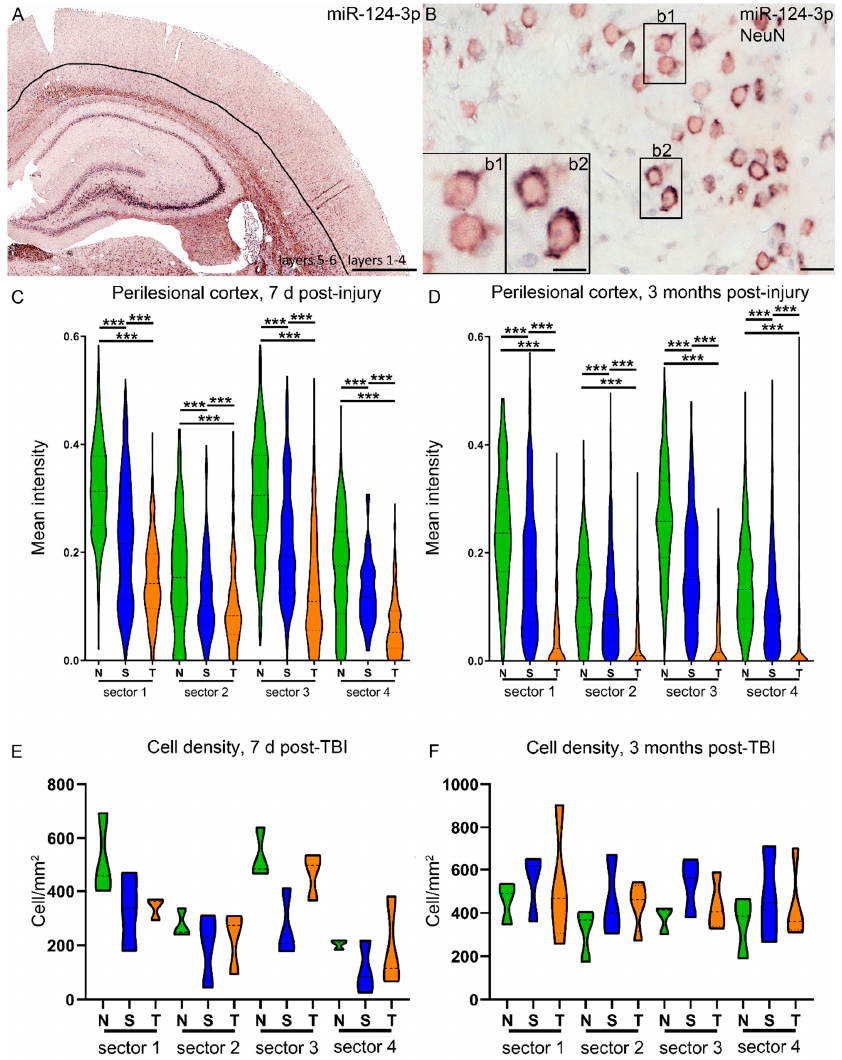
Figure 3. Perilesional expression of miR-124-3p is downregulated by lateral fluid-percussion injury as well as by craniectomy. ( A ) In situ hybridization was used to detect the distribution and intensity of cellular expression of miR-124-3p in di ff erent layers of the cortex. ( B ) Double-labeling with NeuN revealed that the expression level of miR-124-3p varied between the neurons in the perilesional cortex (inserts b1, b2). Our analysis focused on a 1-mm wide area of the dorsal perilesional cortex, which was further divided into four sectors (see Figure 1). The intensity of in situ hybridization signal was measured in the individual neurons within each sector (mean number of cells counted: 7 d, naïve 123; sham 89; TBI 94; 3 months, naïve 125; sham 151; TBI 63). ( C , D ) Naïve animals (N) showed a clear expression pattern at both 7 d and 3 months post-TBI, with a higher level of miR-124-3p expression in the deeper (s1, s3) than superficial layers (s2, s4). The proximal and distal sectors had similar expression levels (s1 vs. s3; s2 vs. s4). In sham-operated experimental controls (S) with a craniotomy, the overall pattern of miR-124-3p expression was preserved. At both time-points and within each of the four sectors, however, the miR-124-3p levels were downregulated compared with those in naïve animals ( p < 0.001). In rats with TBI (T), the miR-124-3p expression levels were even lower than those in sham-operated animals ( p < 0.001) in all sectors and at both time-points. ( E , F ) The cell density in the sectors did not di ff er between time-points or groups. N, naïve; S, sham; s1–s4, sector as described in Figure 1; T / TBI, traumatic brain injury. Statistical significance: *** p < 0.001 (Mann–Whitney U). Scale bars: A 1000 µ m, B 20 µ m, insert in B 10 µ